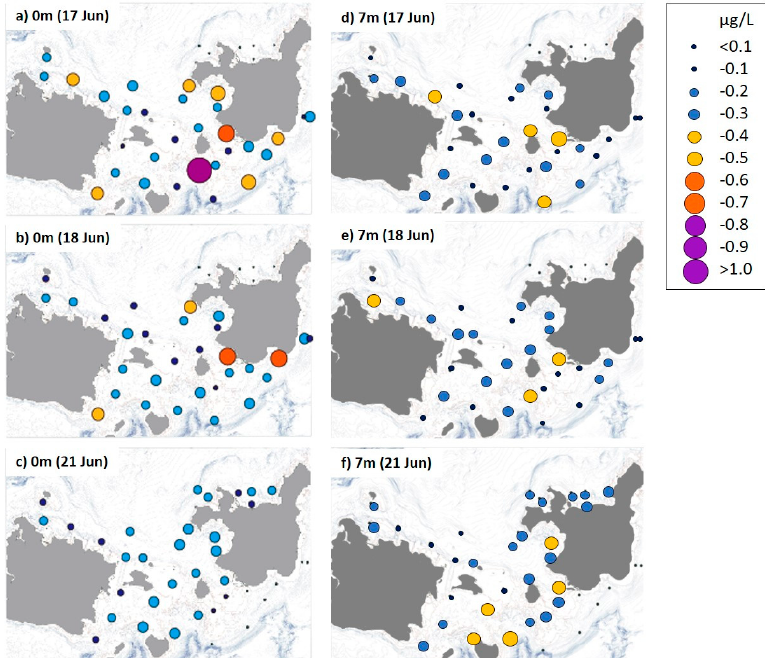
Figure 4. Distribution of chlorophyll (Chl)- a concentrations in Sekisei Lagoon during three sampling days. ( a – c ) sampled at the surface (0 m) and ( d – f ) sampled 7 m below the surface.